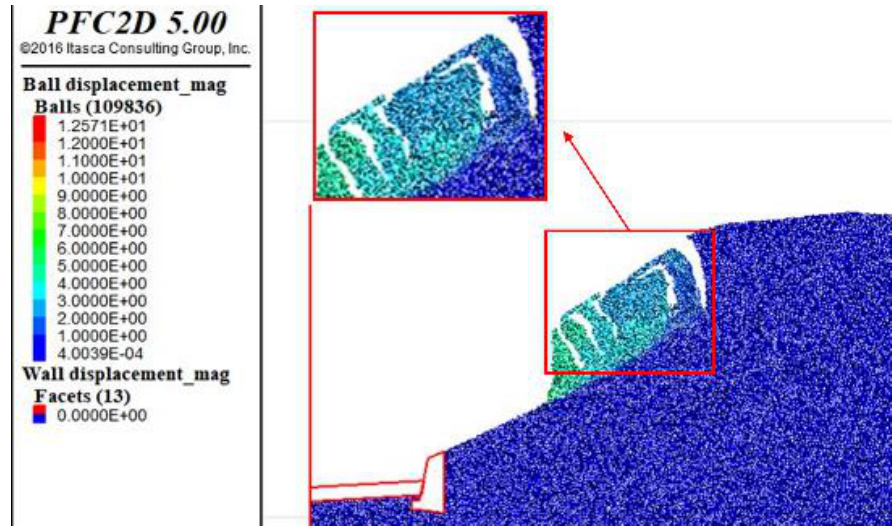
Figure 9. Displacement diagram in the middle of the collapse.